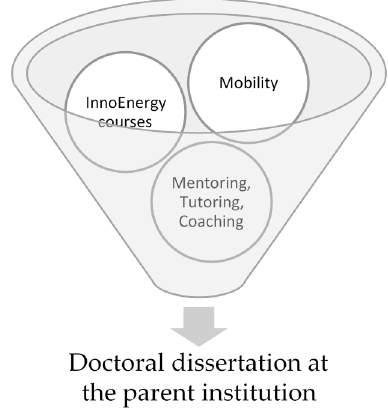
Figure 4. EIT InnoEnergy PhD education structure (source: own elaboration).